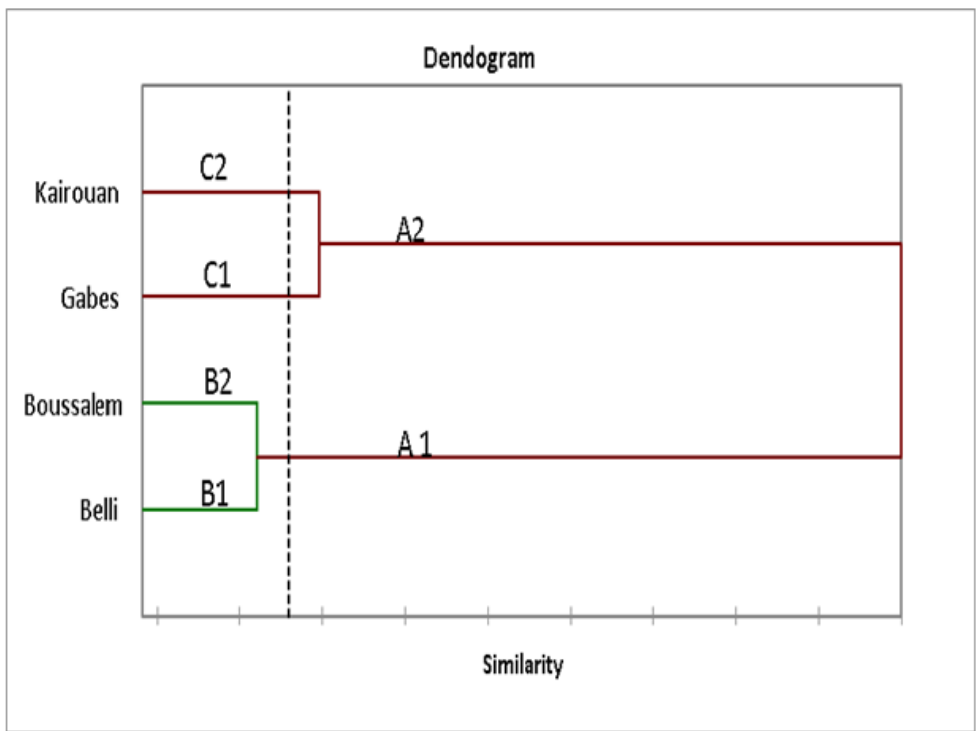
Figure 2. Relative positions of lemon verbena collection regions according to their phenolic composition using a hierarchical ascending classification (HAC).